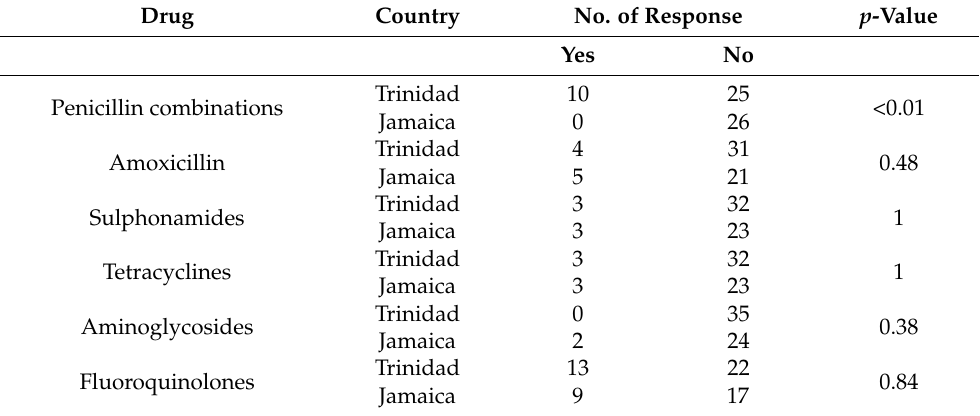
Table 3. The association between country and choice of antimicrobial agent in mixed animal practices in Trinidad and